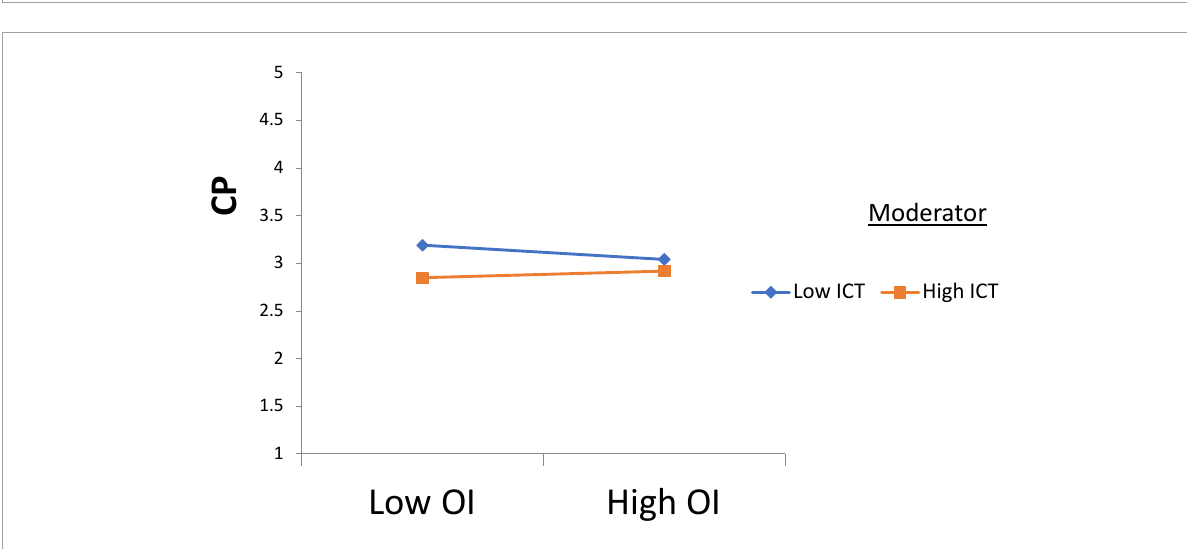
FIGURE6 Moderation effect 4. OI, Open Innovation; ICT, Information Communication Technology; CP, Commercialization